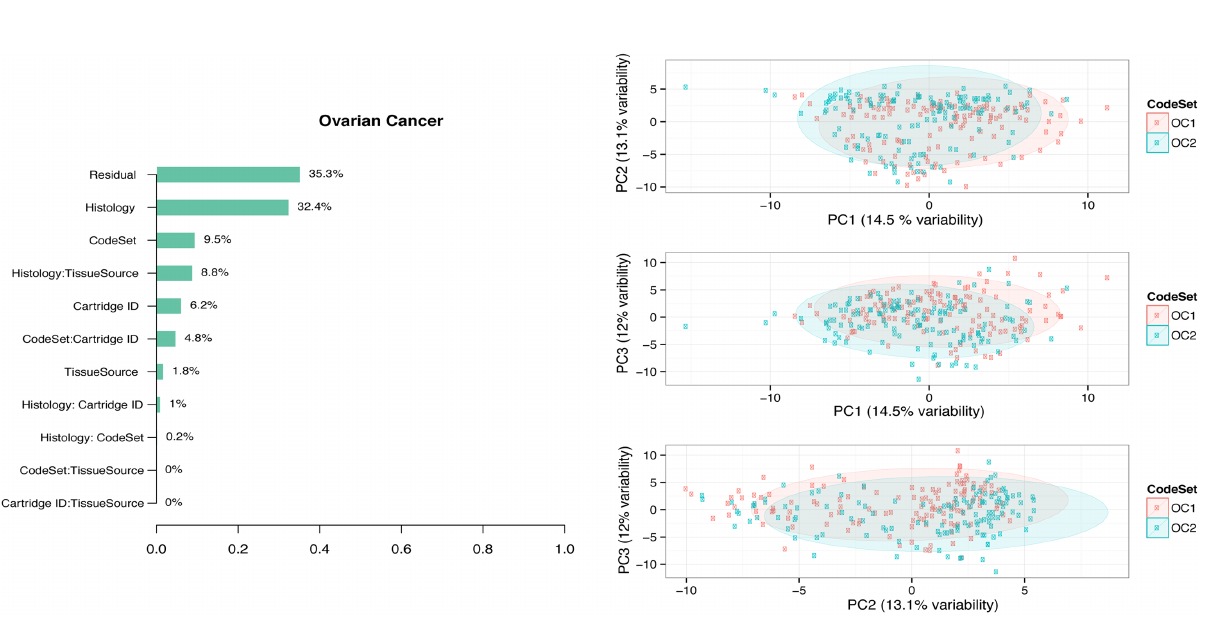
Fig 4. PVCA and PCA plots of the ovarian cancer clinical samples. We considered the PVCA plot (A) of the OC clinical samples run in different batches. The percentages represent the variability explained by each factor and first order interaction between factors. The PCA plot (B) provides a two-dimensional summary of the pairwise plot of the first three principal components, which represent 40% of the variability in the data. CS1, CS2, and CS3 label each of unique CodeSets corresponding to the OC gene list.